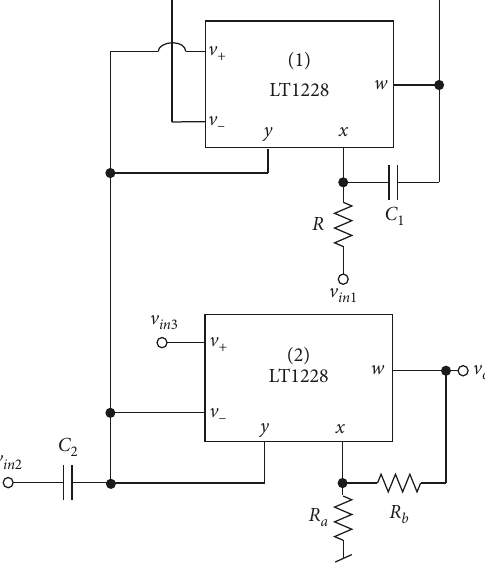
Figure 3: Proposed multifunction active